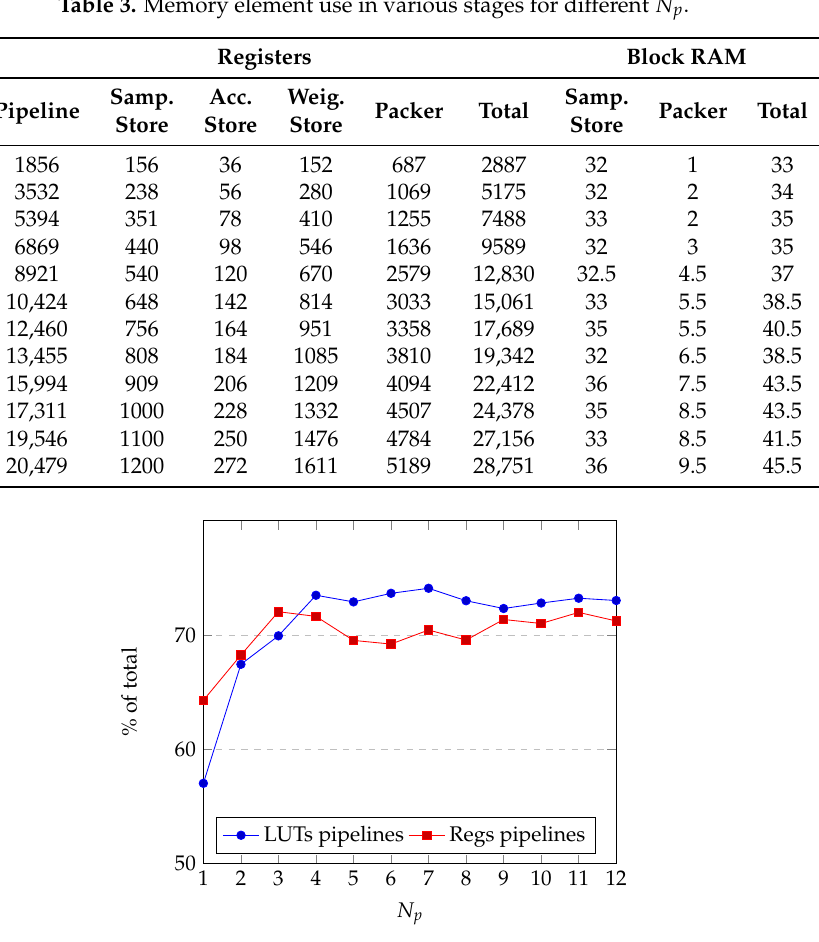
Figure 15. Resource use by pipeline logic with respect to the available resources.